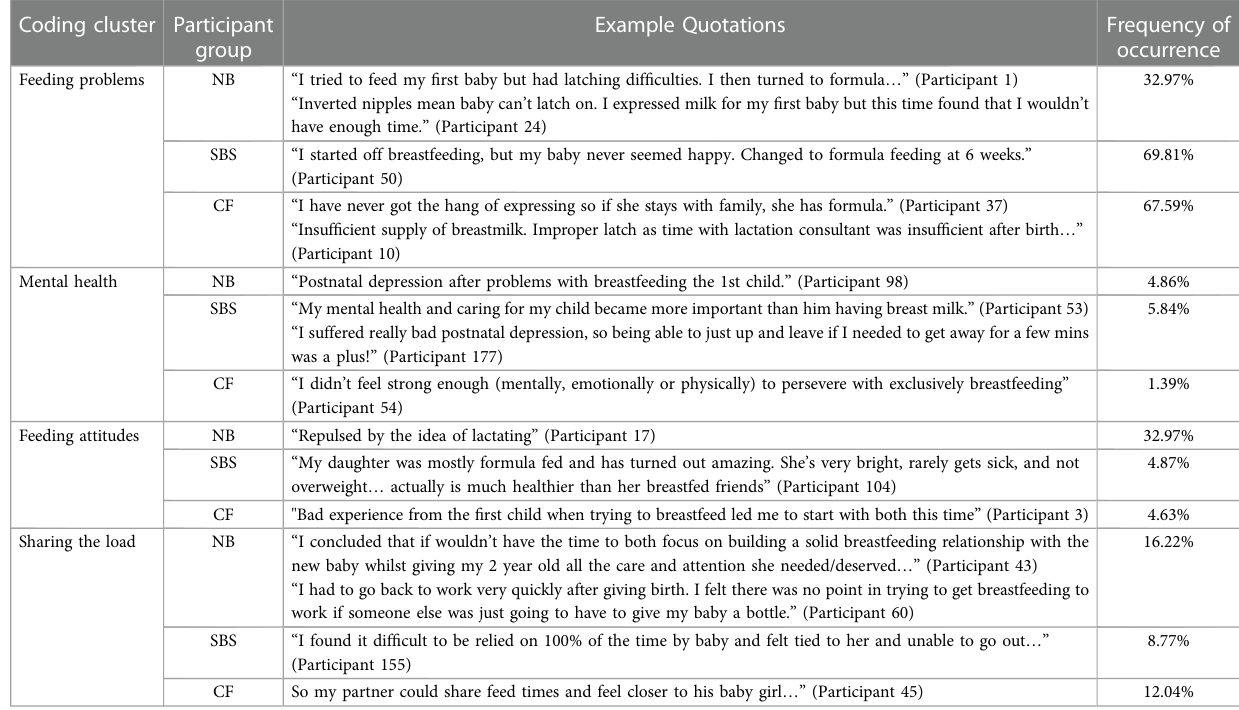
TABLE 1 Clusters of themes identi fi ed from content analysis, with provided examples in the form of statements and percentages. Coding cluster Participant